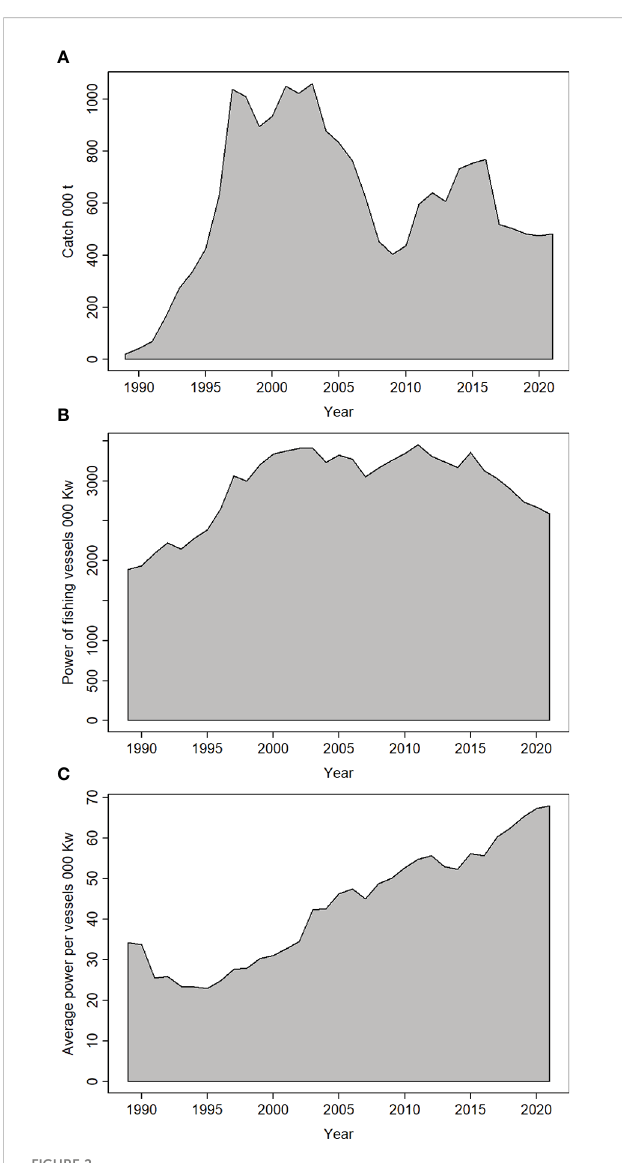
FIGURE 2 (A) Japanese anchovy catch, (B) power of fi shing vessels and (C) average power per vessel from China in the Yellow Sea Large Marine